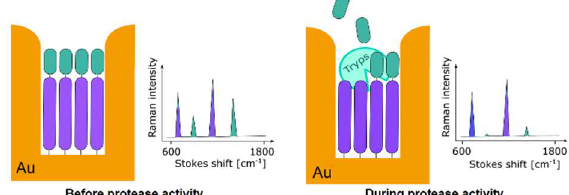
Fig. 1. The concept of protease activity detection via peptide cleavage using surface-enhanced Raman spectroscopy. The peptide forms a monolayer on the gold nanostructures, and is then cleaved by the protease trypsin